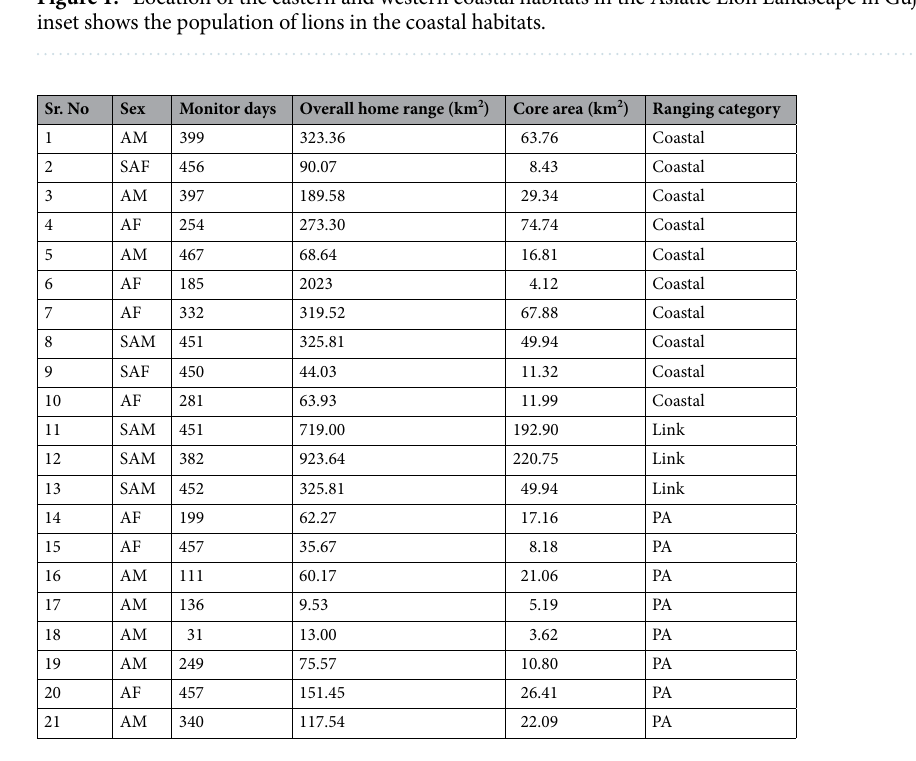
Table 1. Age-sex details of radio-collared lions, number of days monitored, home range (90% Fixed Kernel estimate) and core area (50% Fixed Kernel estimate). Lions ranging exclusively in the coastal habitats, in the landscape between Gir PA and coast, exclusively within Gir PA are categorized as ‘Coastal’, ‘link’ and ‘protected area’ respectively to compare their home range sizes. AM Adult male, AF adult female, SAM sub-adult male, SAF sub-adult female, PA protected